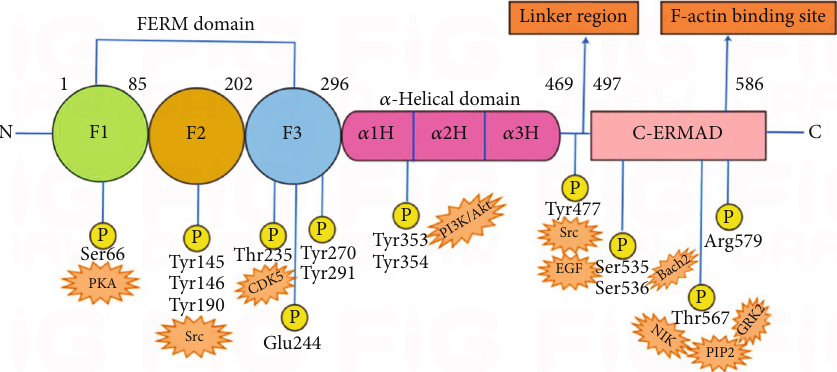
Figure 1: Schematic diagram of the ezrin protein domain. Ezrin protein has two functional domains connected through the α -helical domain: the N-terminal FERM (F for 4.1 protein, E for ezrin, R for radixin, and M for moesin, amino acid 1 – 296) domain and the C- terminal C-ERMAD (amino acid residues 470 – 586). The FERM domain comprises three subdomains (F1: a ubiquitin-like domain; F2: with four α -helices; and F3: a pleckstrin homology domain). C-ERMAD contains F-actin binding sites, which can bind to FERM domains or actin. The central helical (amino acid residues 297 – 469) domain comprises three α helices: α 1H, α 2H, and α 3H, forming a coiled-coil in the monomer structure. Abbreviations: Thr: threonine; Tyr: tyrosine; Ser: serine; Arg: arginine; Glu: glutamic; PIP2: